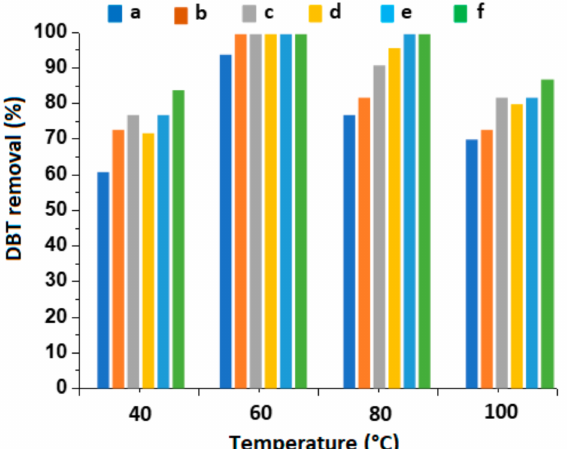
Figure 8. DBT removal at different reaction temperatures. Reaction condition: catalyst loading: 1 g/L oil; H 2 O 2 /DBT molar ratio: 10; reaction time: 60 min; oil/acetonitrile volume ratio: 1:1. ( a ) 10V/SBA- 15; ( b ) 20V/SBA-15; ( c ) 30V/SBA-15; ( d ) 10V/Zr-SBA-15; ( e ) 20V/Zr-SBA-15; ( f )